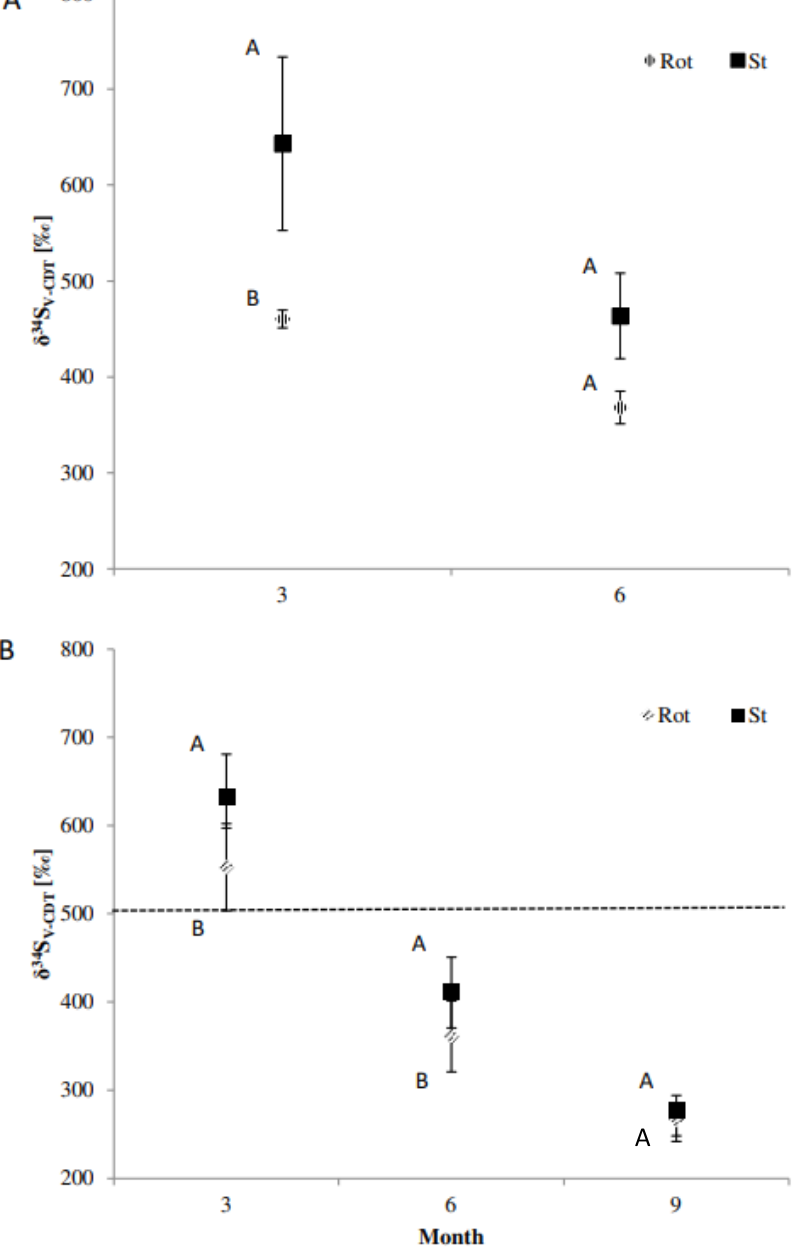
Figure 1. AM uptake of 34 S from organo- 34 S following 3, 6 and 9 months of growth. ( A ) = Plantago lanceolata , ( B ) = Agrostis stolonifera, rotating (Rot) = severed hyphae, and static (St) = mycorrhizal. P. lanceolata was measured at 3 and 6 months, only (3 replicates per treatment). A. stolonifera was measured at 3, 6 and 9 months (all 6 replicates were analysed). Letters (A,B) indicate significant differences. The level of background (leaching) 34 S uptake was measured at 3 months for A. stolonifera and is highlighted (dashed horizontal